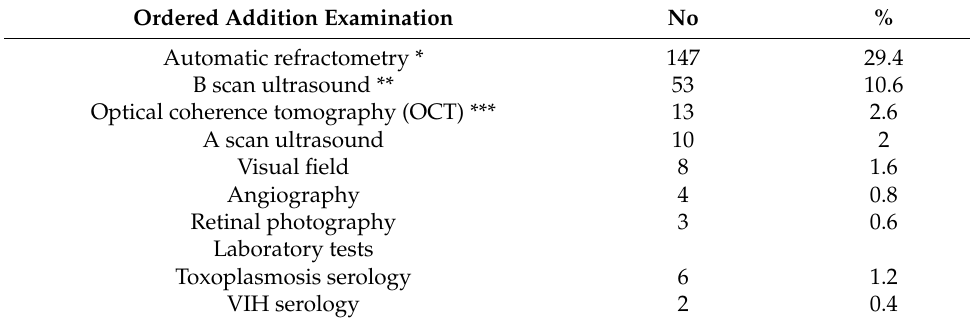
Figure 2. Percentage distribution of the most common diagnosed eye diseases by age groups. Table 3. Specialized examinations.